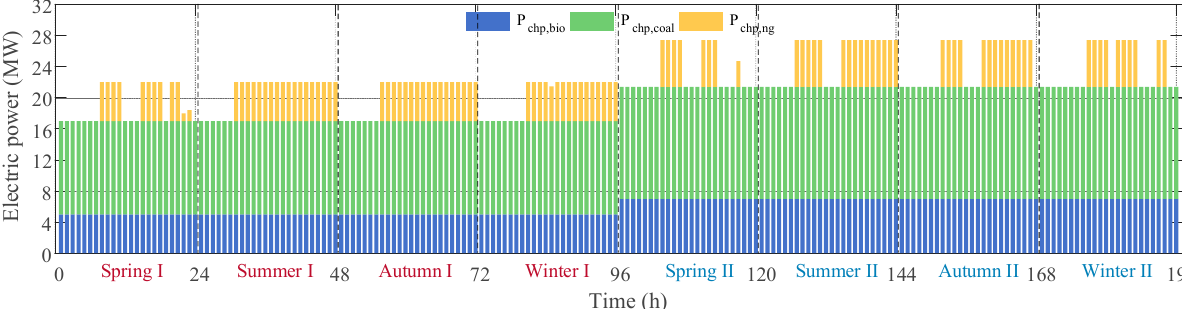
Figure 7. CHP Output in Two Stages of Case 1.